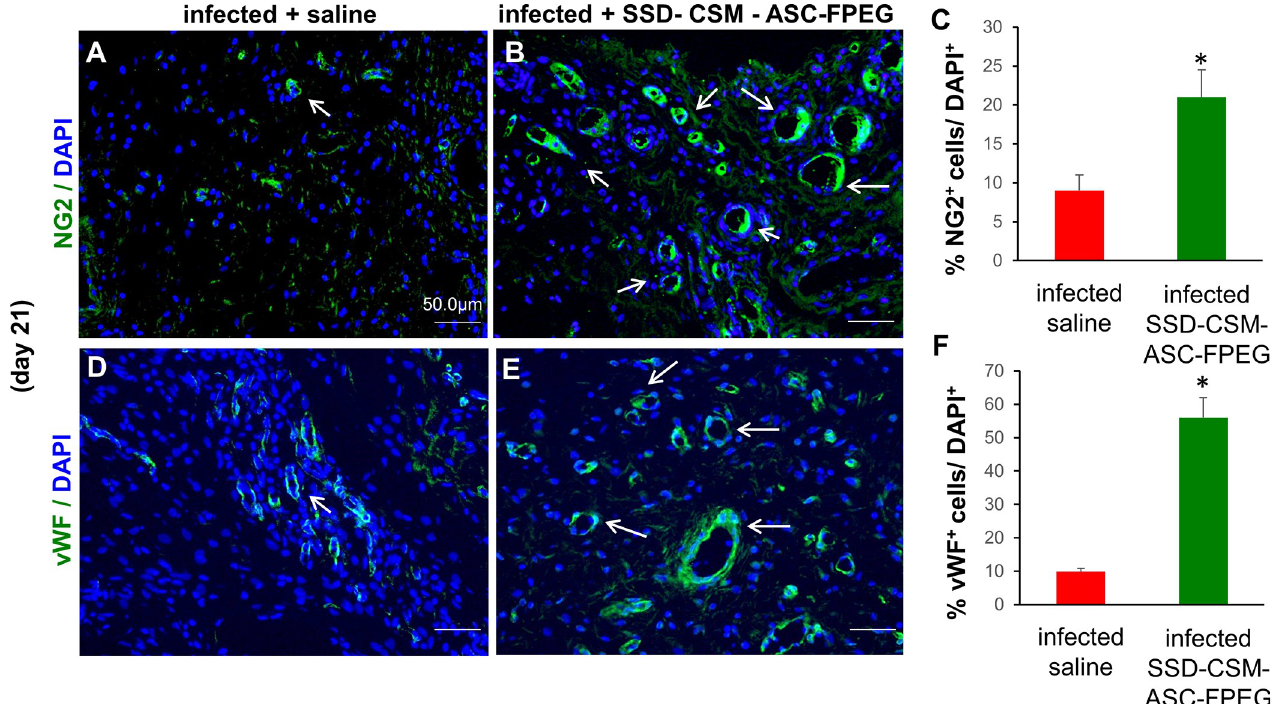
Fig 4. SSD-CSM-ASC-FPEG facilitates neo-vascularization. Day 21 SSD-CSM-ASC-FPEG treated samples exhibit A-C) pericyte marker NG2 expression, indicating neo-vascularization, and D-F) endothelial cell marker von-Willebrand factor (vWF) expression. These markers were not expressed in the infected saline treated samples ( n = 4, p <